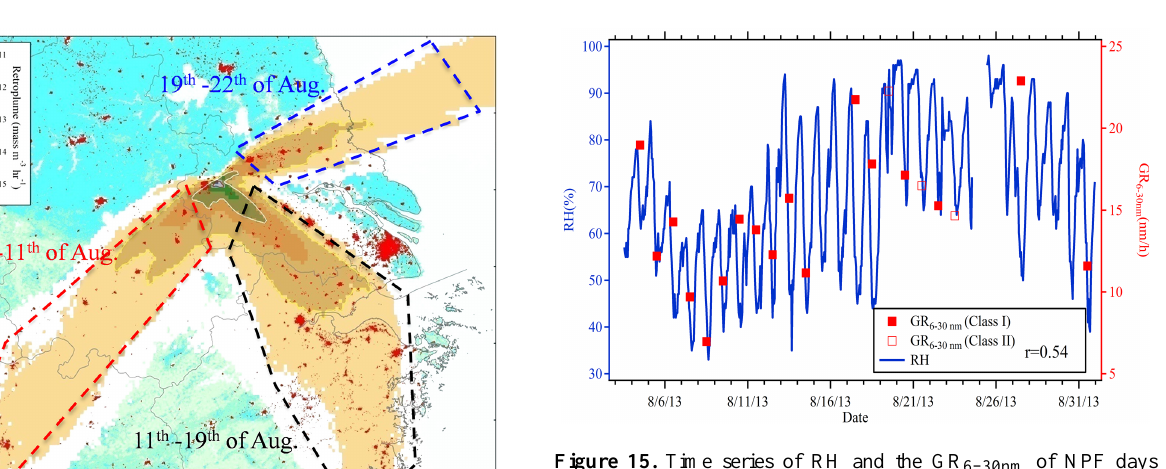
Figure 15. Time series of RH and the GR 6–30nm of NPF days (Class I and Class II) in August